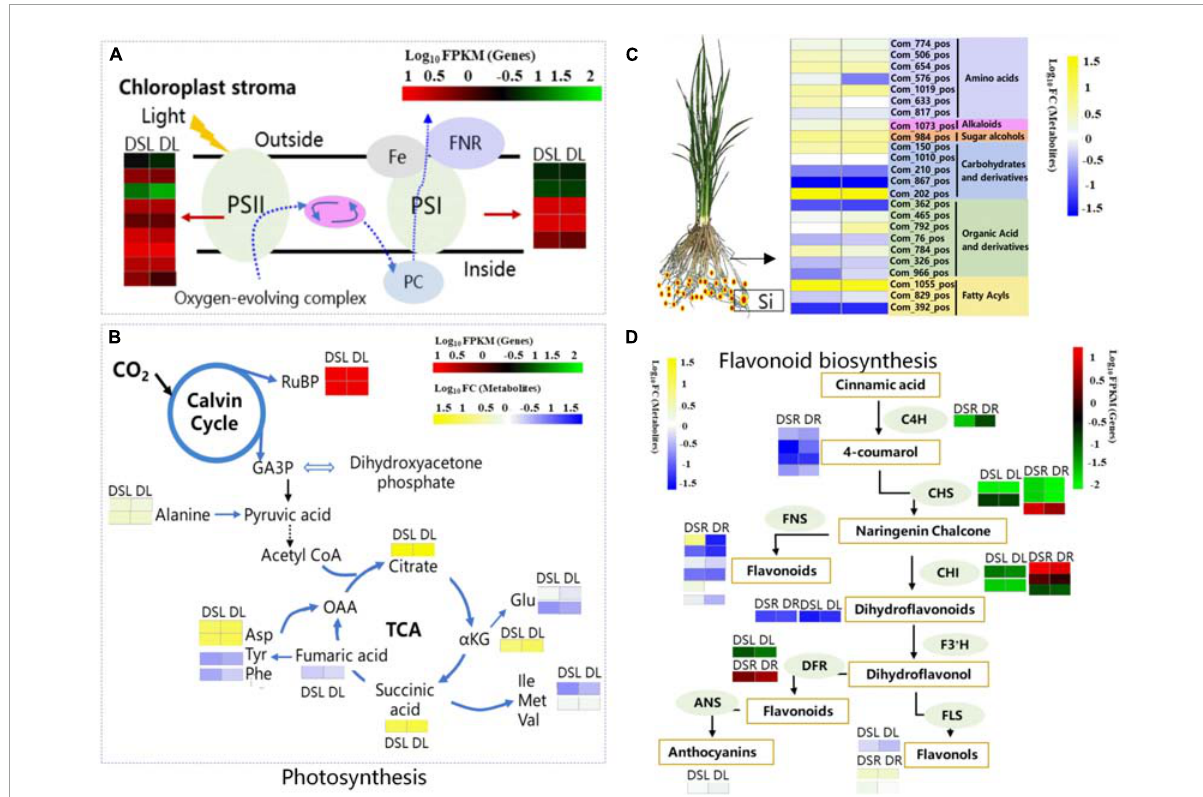
FIGURE6 Summary model of metabolic processes regulated by Si on rice under dry cultivation. (A) Effect of Si on light reaction of rice leaves under dry cultivation. The DEGs in leaves and roots by the shade of red to green according to the color scale. (B) Effect of Si on the Calvin cycle of rice leaves under dry cultivation. The DEGs by the shade of red to green according to the color scale. The DAMs by the shade of yellow to blue according to the color scale. (C) Osmoregulation based on differential metabolites in roots. The DAMs by the shade of yellow to blue according to the color scale. (D) Flavonoid biosynthesis. The DEGs by the shade of red to green according to the color scale. The DAMs by the shade of yellow to blue according to the color scale in leaves and roots. C4H, cinnamic acid 4-hydroxylase; CHS, chalcone synthase; CHI, chalcone isomerase; F3 (cid:48) H, flavonoid 3 (cid:48) -hydroxylase; DFR, dihydroflavonol 4-reductase; ANS, leucoanthocyanidin dioxygenase; FLS, flavonol